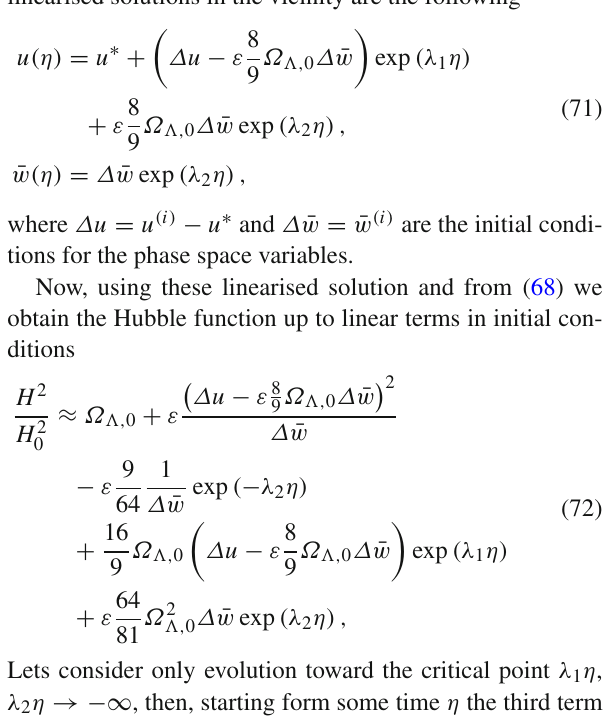
Table 3 Critical points of the system (70) at infinity of the phase space defined as ¯ w = 0 together with values of the acceleration equation